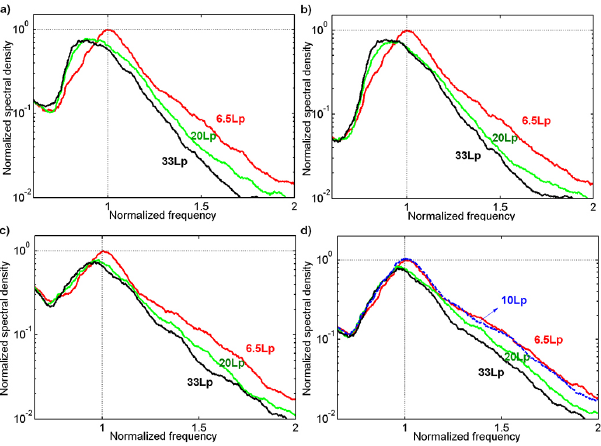
Figure 5. Evolution along the tank of the high-frequency spectral counterparts of the mixed following seas: (a) 8228, (b) 8229, (c) 8230 and (d)